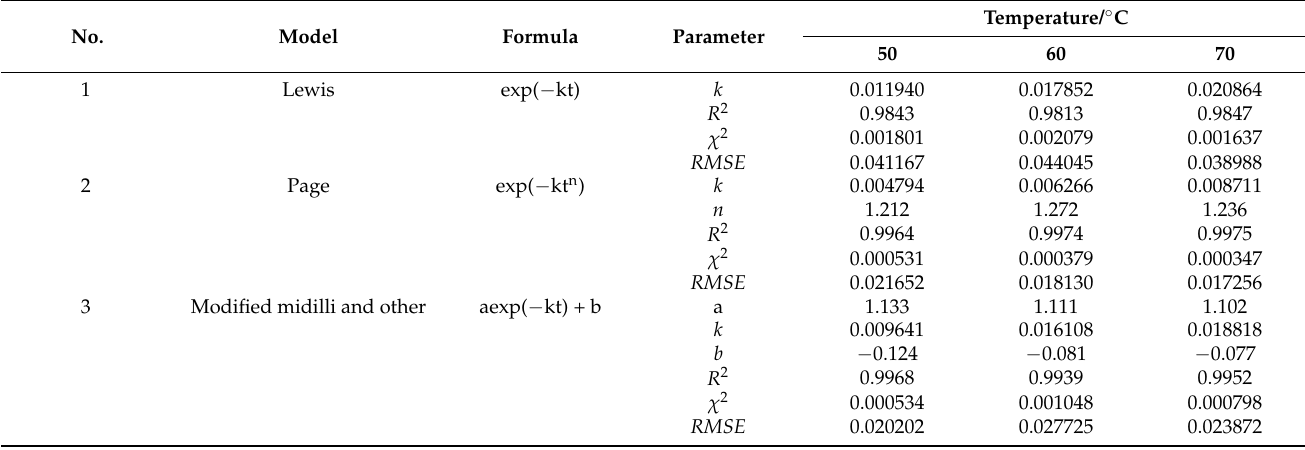
Table 1. Coefficients of different drying models for HAD of blood-flesh peach under different